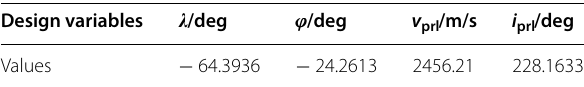
Table 1 The initial values of the design variables by the retrograde semi‑analytical model Design variables